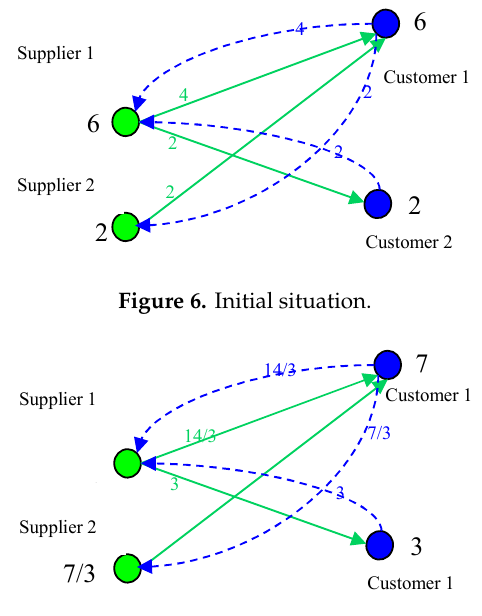
Figure 7. The case of self-organizing